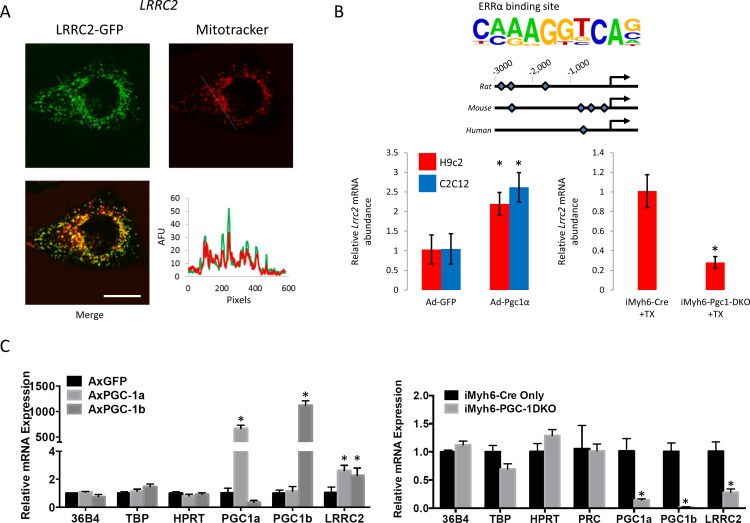
LRRC2 localizes to the mitochondria and is regulated by Pgc-1.A, HEK293 cells expressing a LRRC2-GFP fusion protein were incubated with MitoTracker Red and then imaged via confocal microscopy (left). Chart displays signal co-occurrence (green, LRRC2; red, MitoTracker Red) along the dashed line in unmerged images. Scale bar = 20μm. B, Approximate positions of potential ERRα binding sites in rat, mouse and human LRRC2 genes (top panel), Lrrc2 mRNA abundance in C2C12 and H9c2 cells following infection with either a GFP- or Pgc-1α-encoding adenovirus (bottom-left panel), and Lrrc2 mRNA abundance in the cardiac-specific inducible Pgc-1α/β double-knockout (DKO) mouse 3 weeks post-tamoxifen (TX) treatment (bottom-right panel). C, Transcript abundance of Lrrc2 and control transcripts (36b4, Tbp and Hprt) as well as Pgc-1α/β in C2C12 cells following adenovirus-mediated over-expression of Pgc-1α and Pgc-1α/β. D, Transcript abundance of Lrrc2 and control transcripts (36b4, Tbp and Hprt) as well as Pgc-1α/β in hearts of cardiac-specific Pgc-1α/β double knockout (DKO) mice and Cre only control mice. All QPCR data are represented as means ± s.e.m and are derived from three independent experiments. *, P≤0.05.